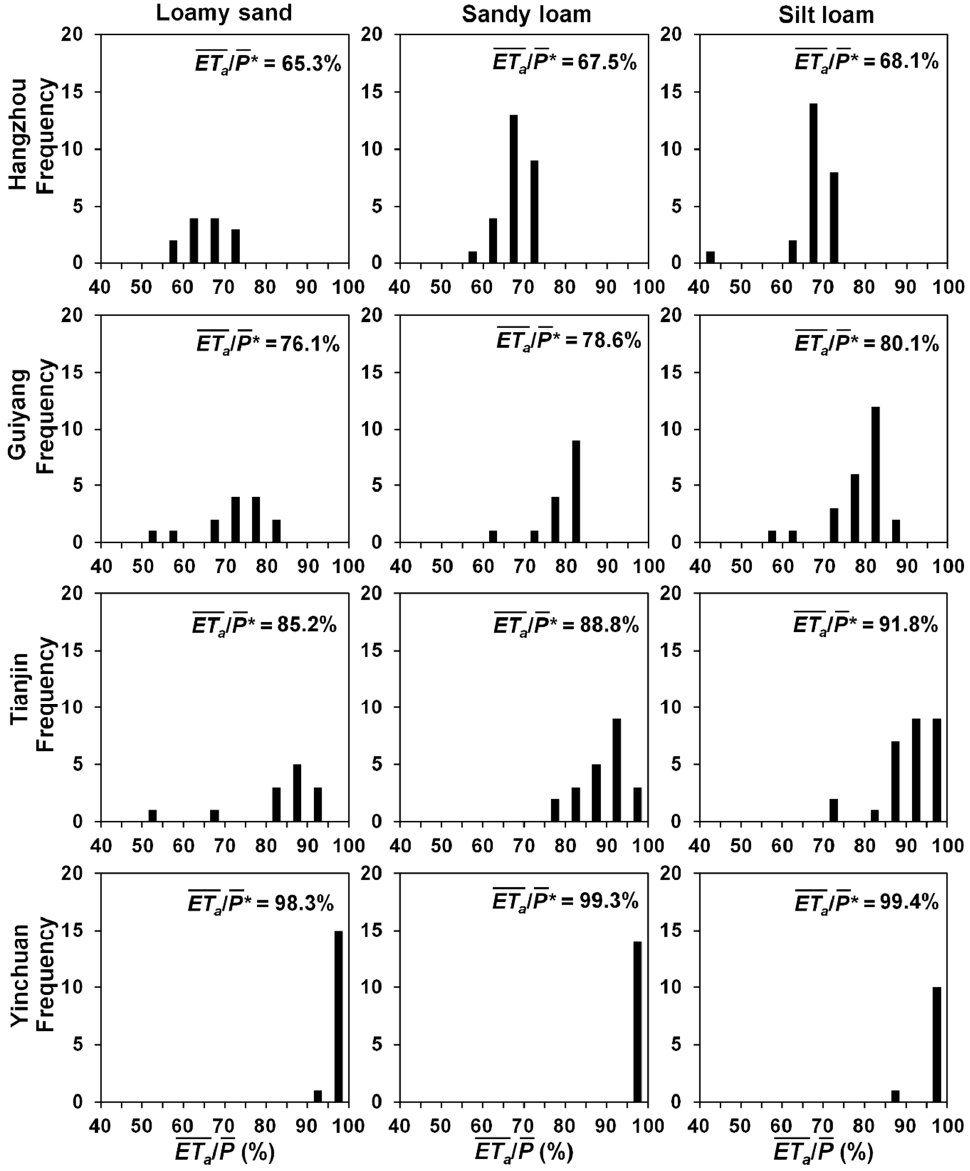
Figure 5. Distributions of mean annual ratio of actual evapotranspiration ( ET a ) over precipitation ( P ). Samples with MRD < ±0.05 are used here to plot the distributions of 𝐸𝑇 (cid:3028) (cid:3364)(cid:3364)(cid:3364)(cid:3364)(cid:3364) 𝑃(cid:3364)⁄ . 𝐸𝑇 (cid:3028) (cid:3364)(cid:3364)(cid:3364)(cid:3364)(cid:3364) 𝑃(cid:3364) ∗ ⁄ is the average value of 𝐸𝑇 (cid:3028) (cid:3364)(cid:3364)(cid:3364)(cid:3364)(cid:3364) 𝑃(cid:3364)⁄ from all samples.